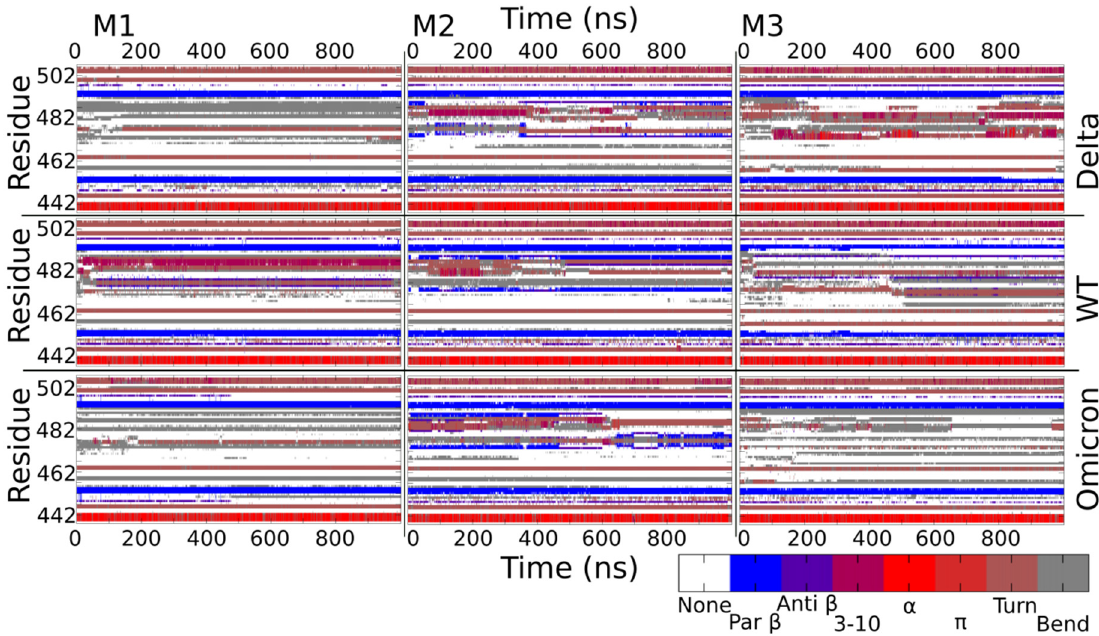
Figure 8. Secondary structure content as a function of the simulation time in M1, M2, and M3 of Delta, WT, and Omicron in the RBM